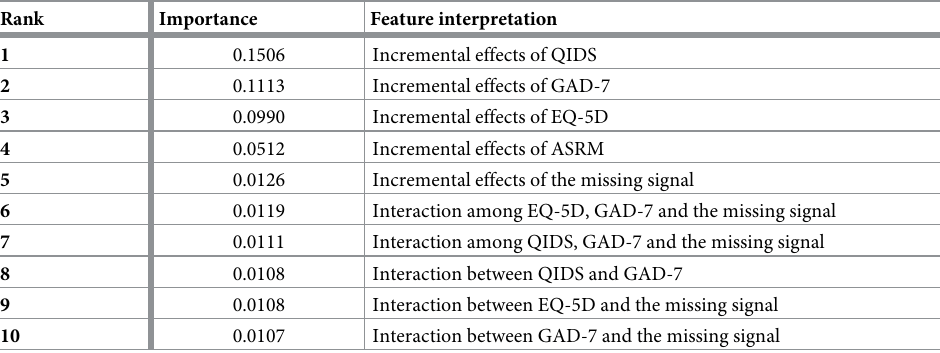
Table 5. Feature importance of the